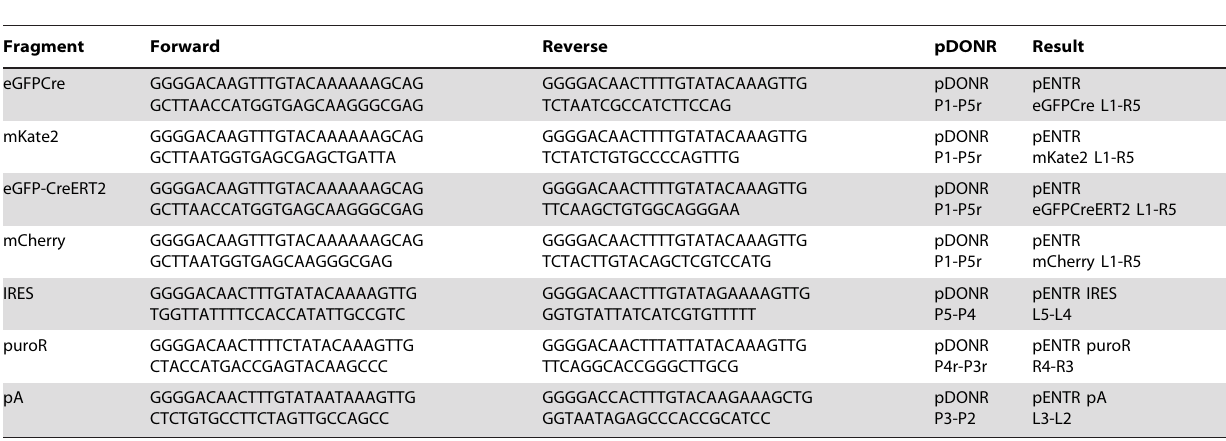
Table 1. Primers and pDONR vectors used in the generation of pENTR